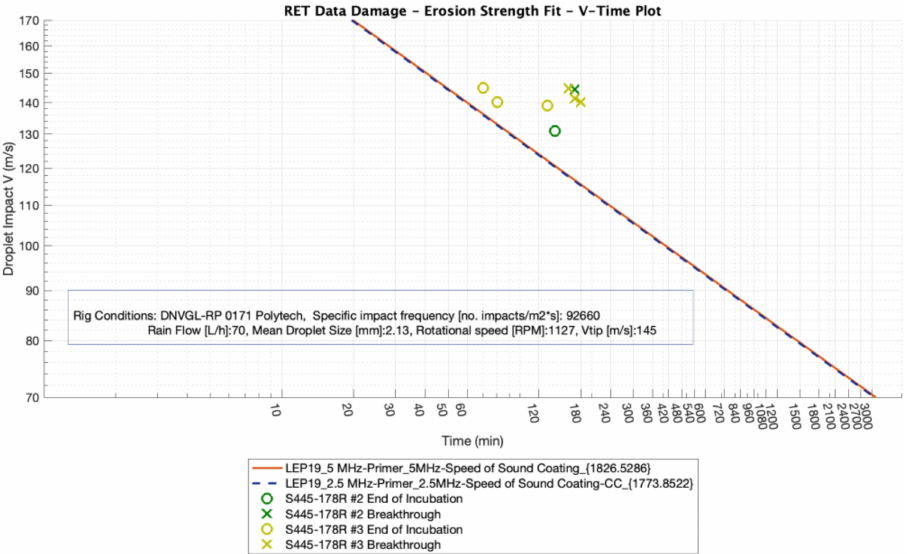
Figure 17. V-Time plot for simulated coating LEP prototype, comparing both the e ff ect of the droplet impactvelocityvariationsthroughtheRETcouponfromtheroottothetip, accordingtoDNVGL-RP-0171 and the comparing the simulated results when UT measuring at 2.5 and 5 MHz.